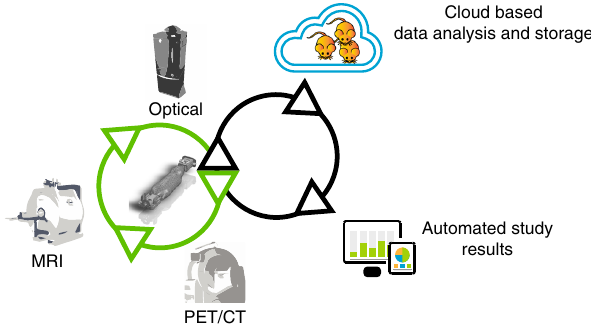
Fig. 8 Schematic of cloud-based data analysis platform for multimodal preclinical imaging. The BCAM and the OPM are part of a platform technology, which connects different imaging systems (e.g., optical, PET/ CT, and MRI) to enable automated cloud-based data analysis. Collected images are uploaded via a browser-based web interface to a server for data annotation, storage, analysis, and automated study report generation. Automation by this machine moves the investigator from in the loop, to on the loop, which will improve accuracy and reproducibility of small animal imaging